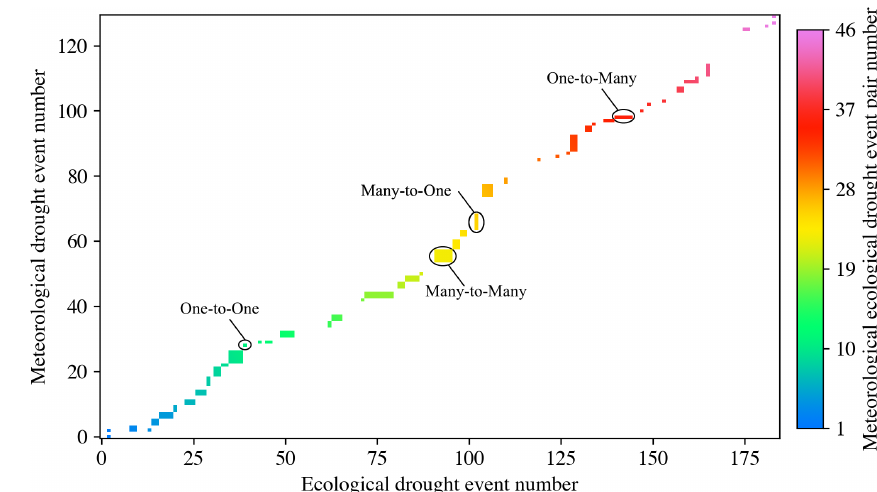
Figure 4. Identification results of paired meteorological and ecological drought events.